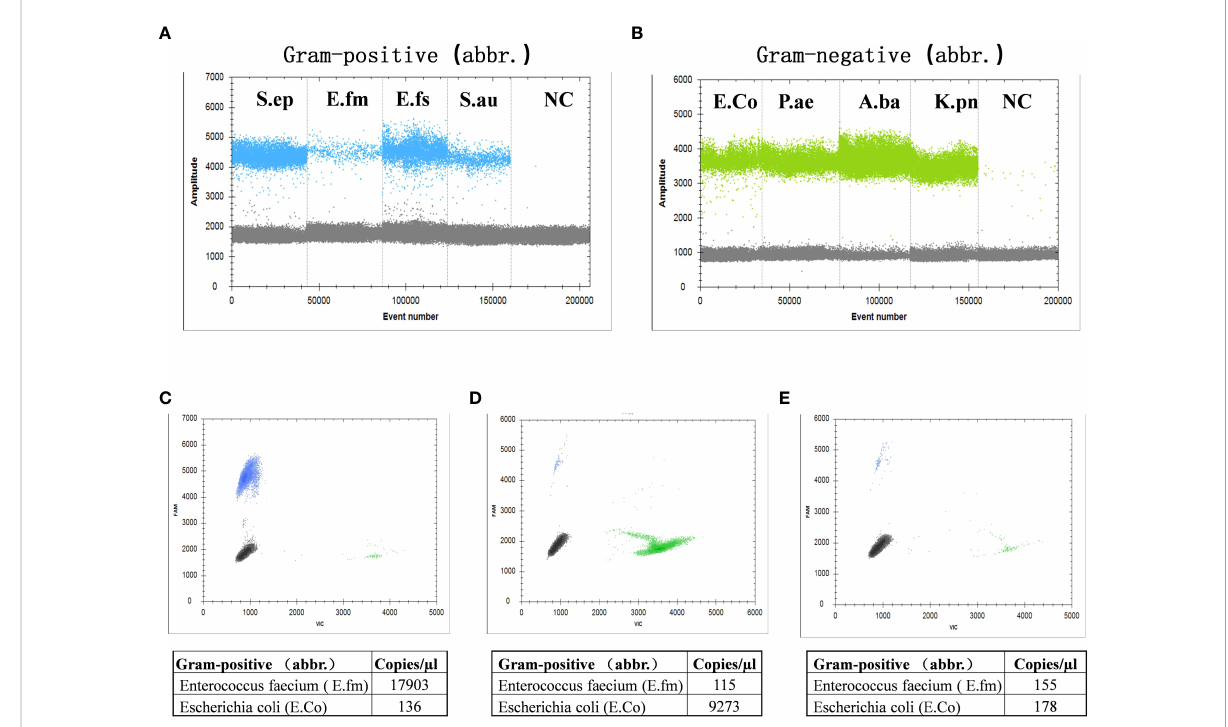
FIGURE 2 Detection of Gram-positive bacteria and Gram-negative bacteria using ddPCR. (A) Gram-positive bacteria, which included Staphylococcus epidermidis , Enterococcus faecium , Enterococcus faecalis , Staphylococcus aureus , and a negative control. (B) Gram-negative bacteria, which included Escherichia coli , Pseudomonas aeruginosa , Acinetobacter baumannii , Klebsiella pneumoniae , and a negative control. The interference test (different/mixed concentrations) of mixed E. faecium and E. coli ; (C) 100:1; (D) 1:100; (E)